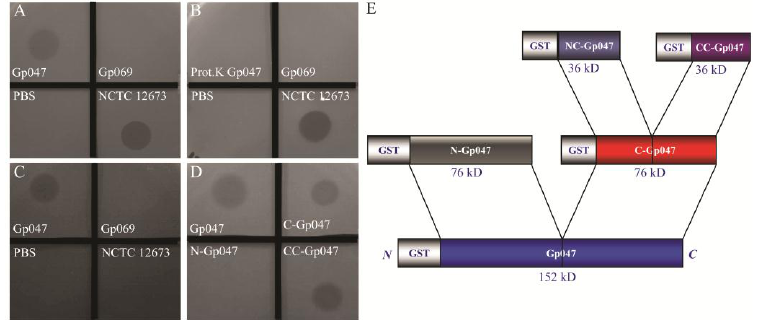
Figure 1. C. jejuni growth clearance assays. GST-Gp047 and phage NCTC 12673 showed